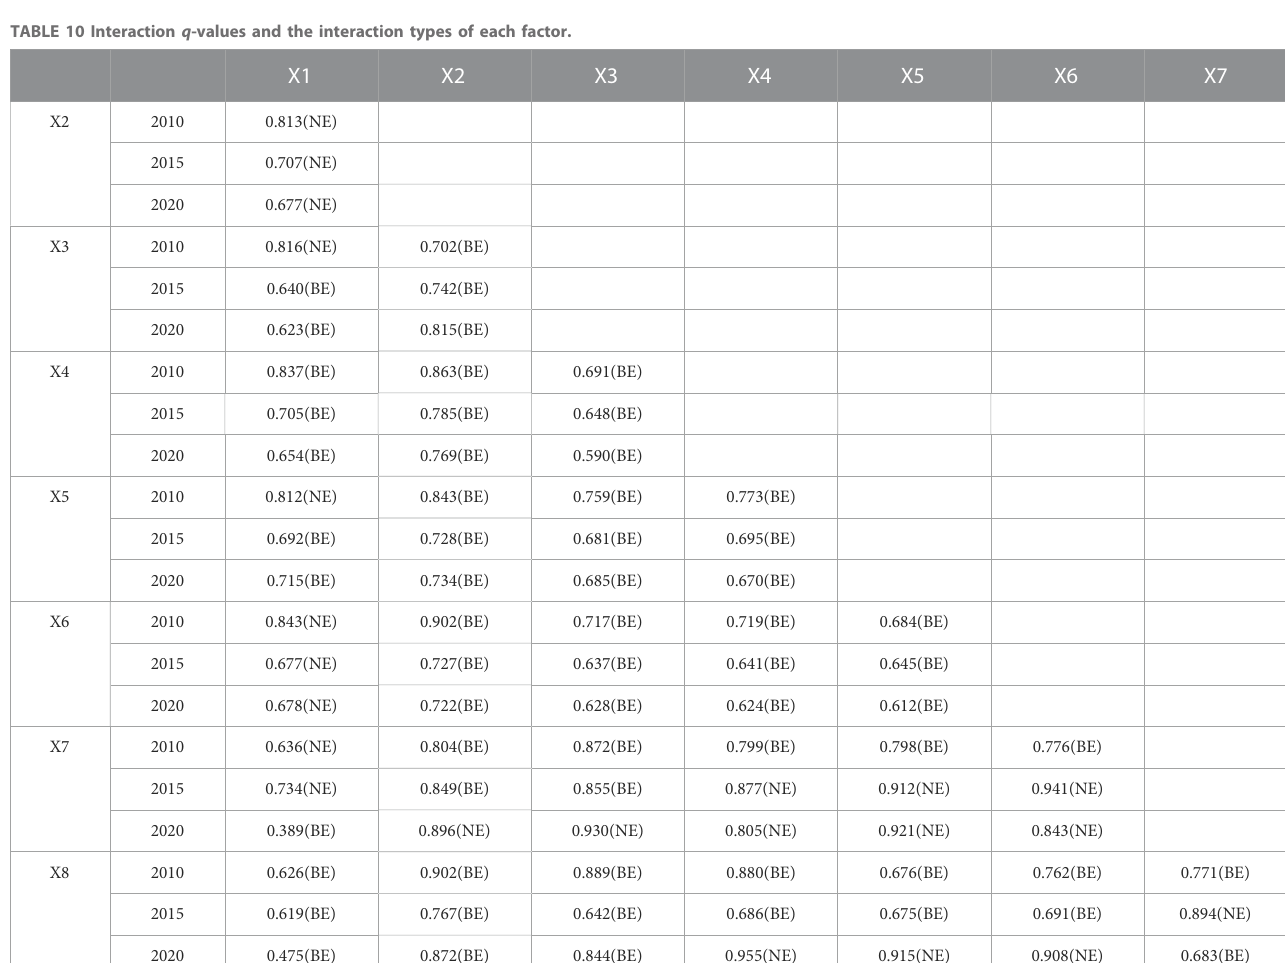
TABLE 10 Interaction q -values and the interaction types of each